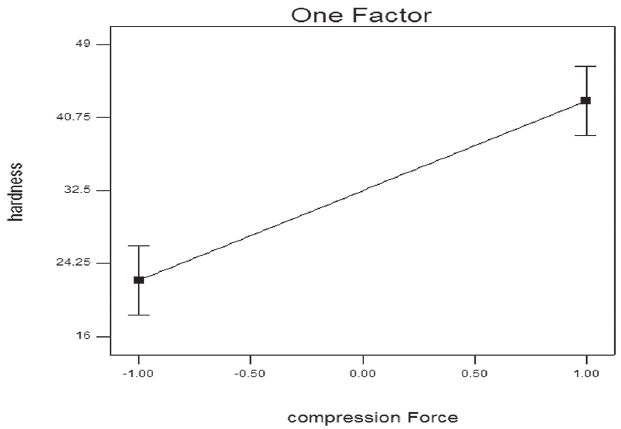
FIGURE 4 - Effect of compression force on the hardness of MLX ODT.